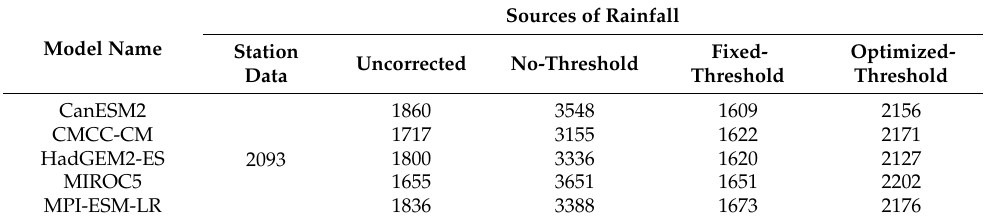
Table 5. Results of different rainfall sources (annual runoff of watershed).